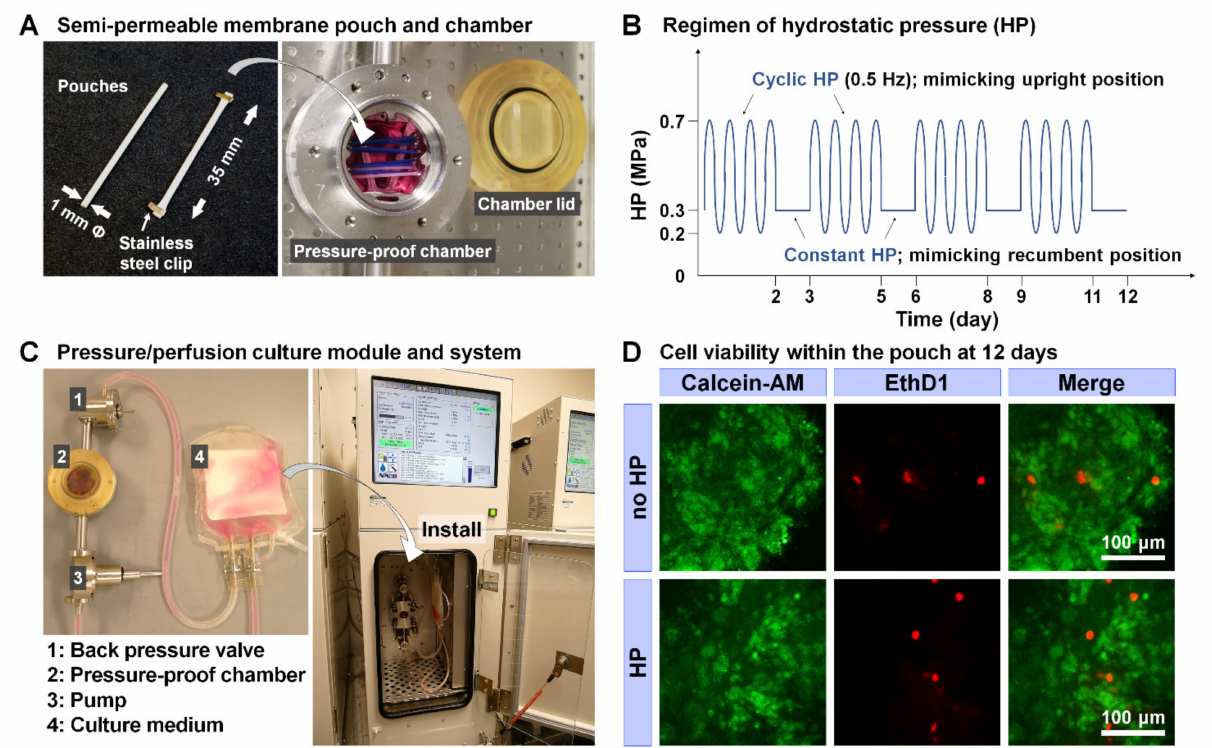
Figure 4. Our semi-permeable membrane pouch culture module and pressure/perfusion culture system. ( A ) Semi- permeable membrane pouches and a pressure-proof chamber. ( B ) Repetitive regimen of 2-day cyclic followed by 1-day constant hydrostatic pressure (HP). ( C ) Macroscopic appearance of pressure/perfusion culture module and system. ( D ) Validation of bovine nucleus pulposus cell viability at 12 days. Calcein-AM indicates live cells and ethidium homodimer-1 (EthD1) indicates dead cells. The bar indicates 100 µ